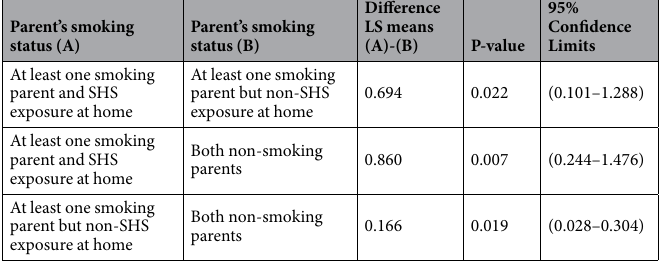
Table 4. The results of the ANCOVA analysis with Tukey’s post-hoc tests on the differences in urinary NNAL levels (N = 486, alpha = 0.05). Age, sex, and SHS exposure in public place were adjusted. Post-hoc test was used creatinine-corrected cotinine and log-transformed values.